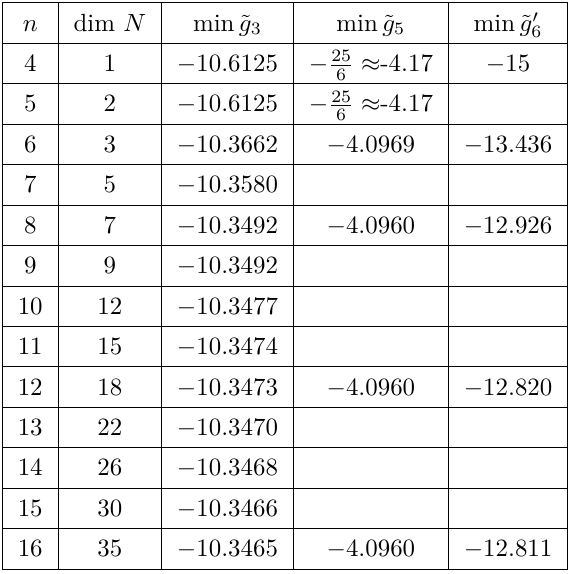
Table 2. Convergence of the “box bounds” (4.2) with increasing Mandelstam order n , which results in larger sets of orthogonal constraints N = { n bounds would be −∞ since no null constraints exist at that